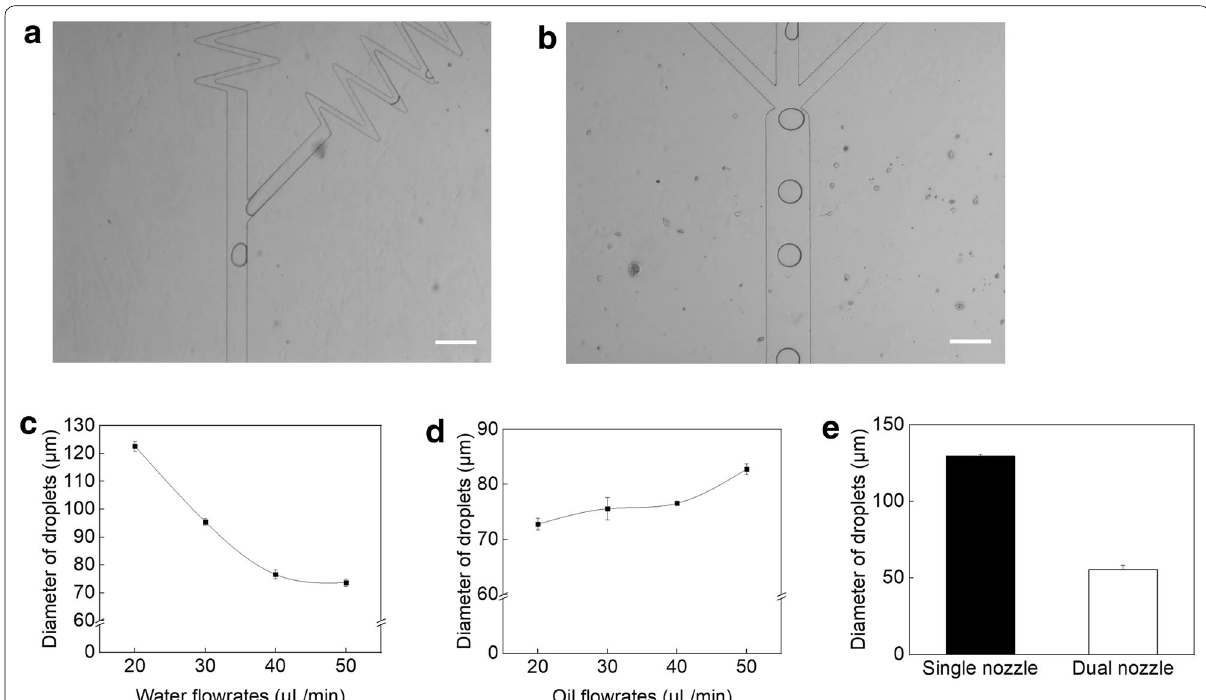
Fig. 4 Droplet generation and spacing using dual-nozzle microfluidic device. Microscope image of droplet generation at first nozzle ( a ) and control of droplet distance at second nozzle ( b ). Scale bars are 200 µm. Graphs of diameter of droplets generated at first nozzle against water flowrate ( c ), and oil flowrate ( d ), and bar diagram of dispensed droplet diameter at device outlet using a single nozzle and the dual-nozzle setup ( e